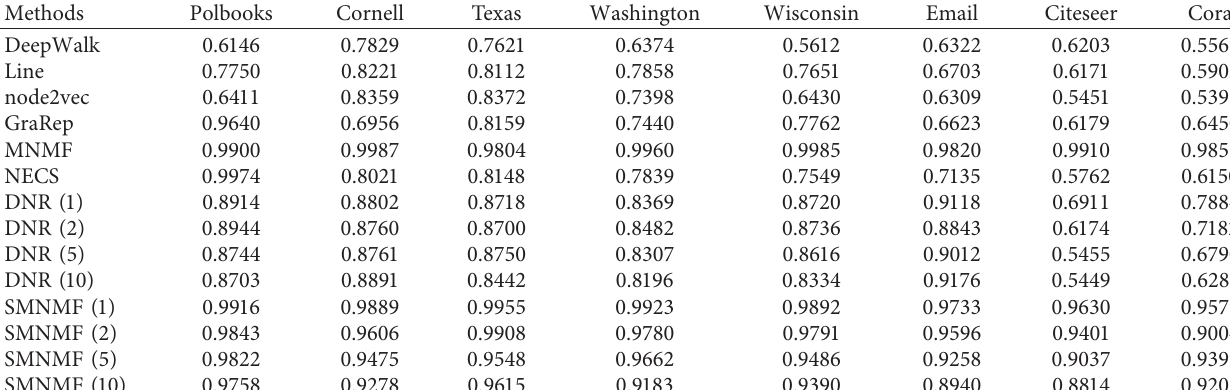
Table 6: AUC-ROC of link prediction (70% training set and 30% test